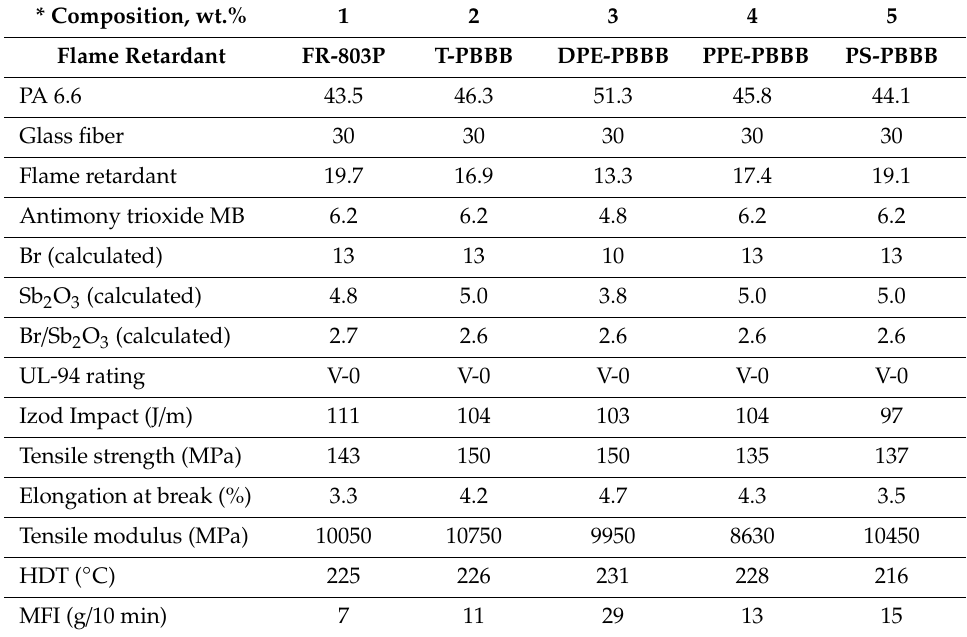
Table 6. Flammability performance and physical properties of glass-filled polyamide 6.6. * Composition,